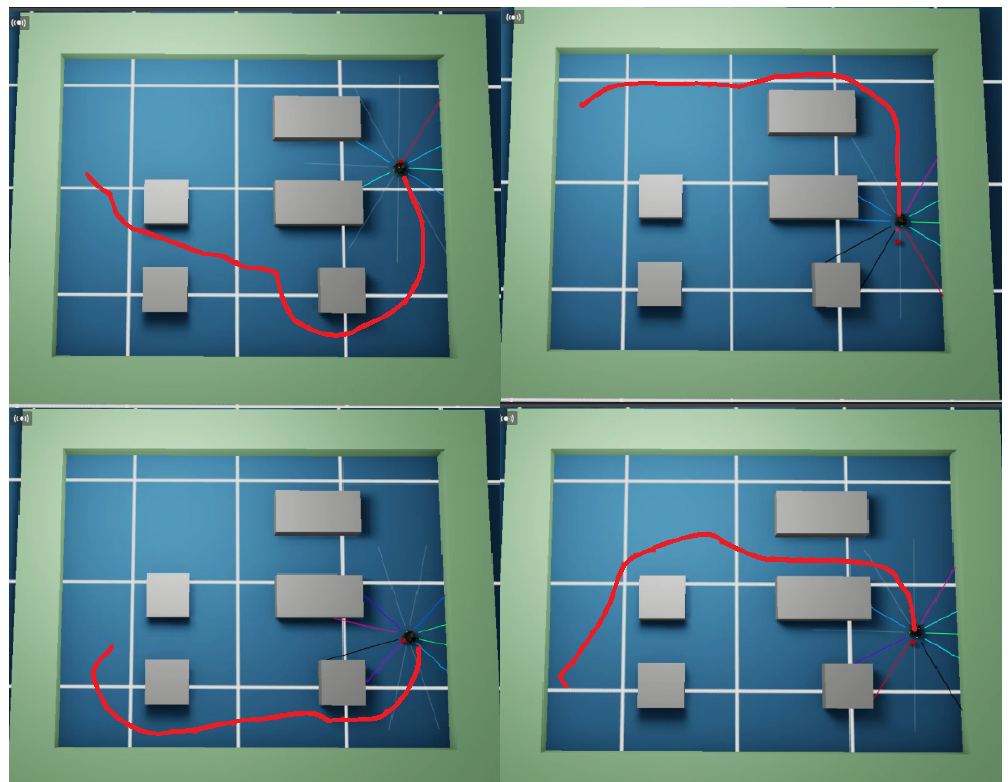
Figure 9. Agent’s learned trajectories in Isaac Sim simulator with a custom